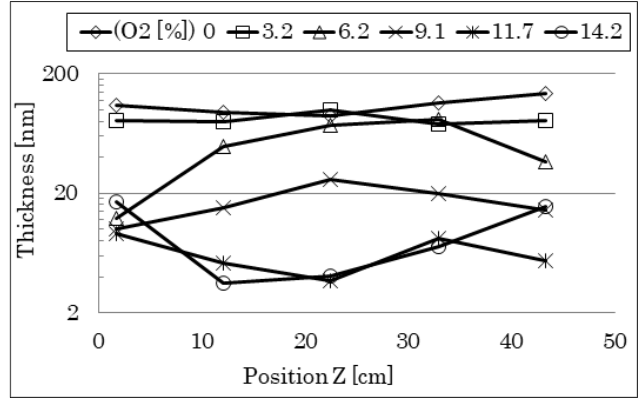
Figure 6. Distribution of the film thickness along the axial position at different fractions of O 2 (%) in the case without the Al outer anode.